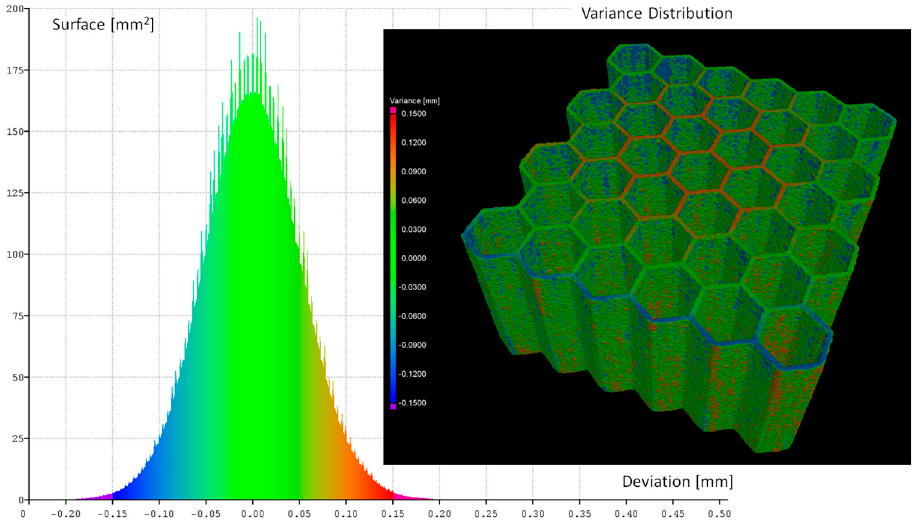
Figure 9. Geometrical quality control of specimen No. 4 before versus after heat